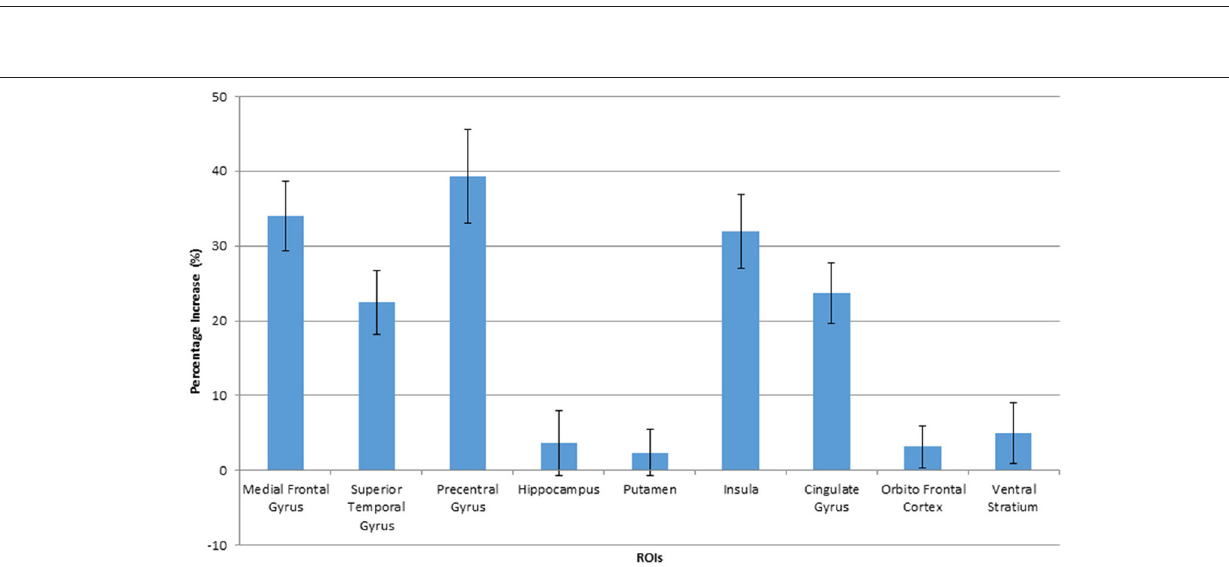
Frontiers in Psychology | www.frontiersin.org